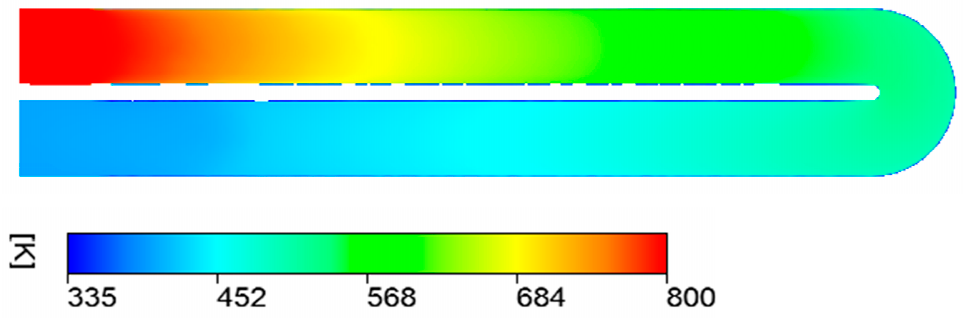
Figure 5. Temperature distribution across a slice (Y direction) inside the fire tube.